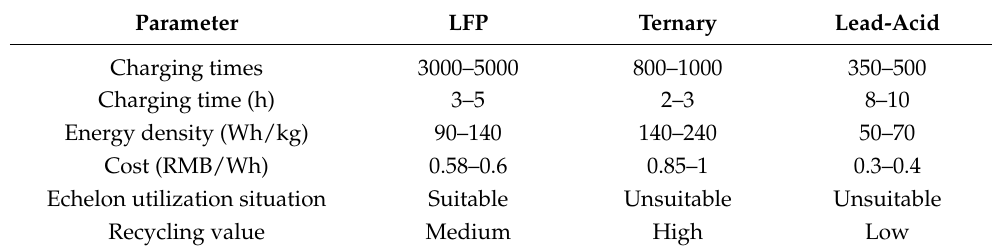
Table 2. Performance comparison of the three